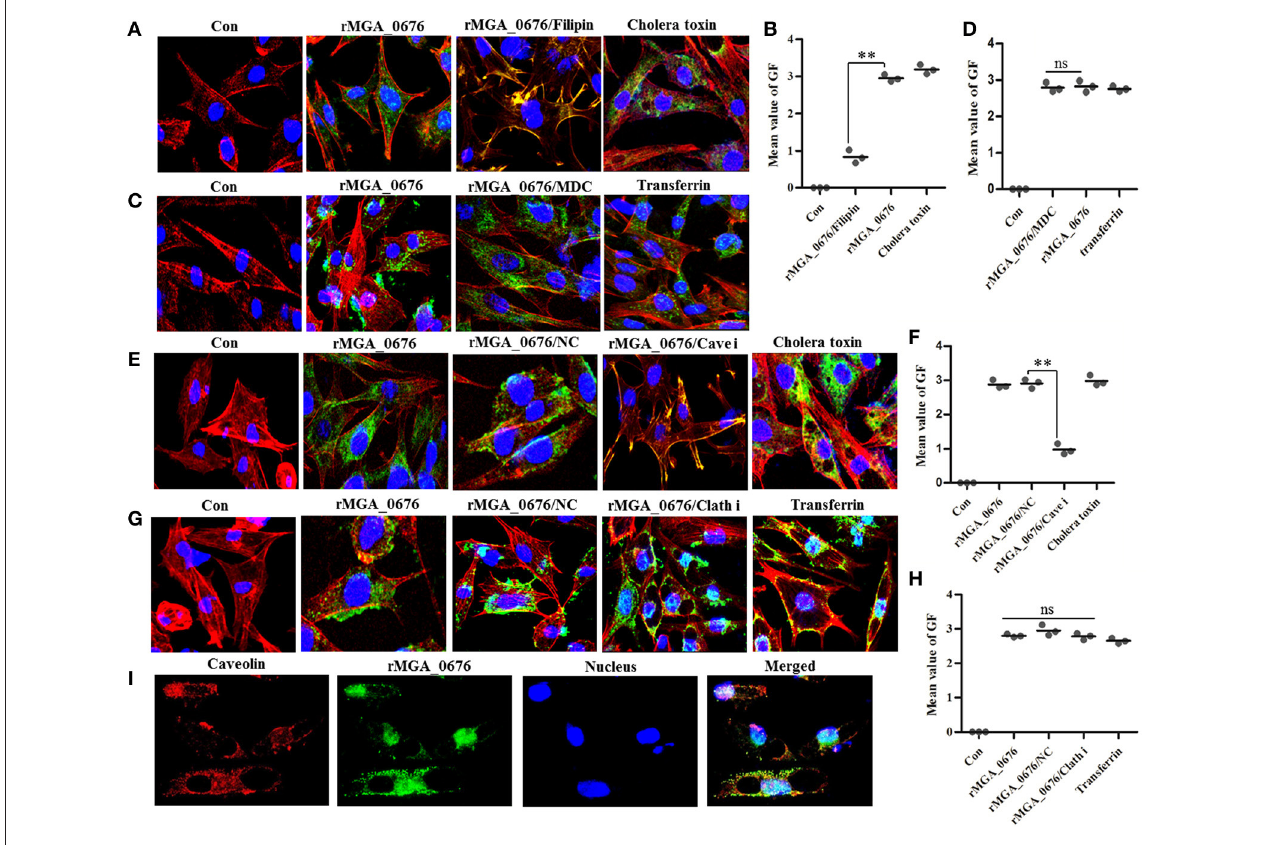
FIGURE 1 | Caveolin-mediated endocytic mechanisms are implicated in internalization of rMGA_0676. (A) Internalization of rMGA_0676 was blocked by caveolin-mediated endocytic inhibitor filipin. DF-1 cells were treated with filipin followed by rMGA_0676 (40 µ g/ml) for 24h at 37 ◦ C to detect the inhibition of rMGA_0676 internalization. The samples underwent IFA and were examined with a laser confocal scanning microscope. Cellular F-actin was stained with Alexa Fluor 555-conjugated phalloidin. The nuclei were counterstained with DAPI (blue). The rMGA_0676 was hybridized with mouse anti-His monoclonal antibody and labeled with FITC-conjugated goat anti mouse IgG antibody green fluorescence (GF). The normal DF-1 cells as the negative control (Con), cells were treated with Cholera toxin-FITC as the caveolin-mediated endocytic positive control (Cholera toxin). (B) The mean value of GF was used to quantify the positive staining for rMGA_0676 in filipin treated DF-1 cells (A) , the data were analyzed using SPSS software, and the graph was made using GraphPad Prism 5.0. “**”represented statistically significant differences ( P < 0.01). (C) Internalization of rMGA_0676 was not blocked by clathrin-mediated endocytic inhibitor MDC. DF-1 cells were treated with MDC followed by rMGA_0676 (40 µ g/ml) for 24h at 37 ◦ C and detected the inhibition of rMGA_0676 internalization underwent IFA as described above. The normal DF-1 cells as the negative control (Con), cells were treated with transferrin as the clathrin-mediated endocytic positive control (transferrin). (D) The mean value of GF was used to quantify the positive staining for rMGA_0676 in MDC treated DF-1 cells (B) , the data were analyzed using SPSS software, and the graph was made using GraphPad Prism 5.0. (E) Internalization of rMGA_0676 was reduced by knockdown of caveolin in DF-1 cells by siRNA. The caveolin siRNA sequence(si Cave) and its negative control siRNA sequence(NC) were transfected into DF-1 cells using RNAiMAX reagent followed by rMGA_0676 (40 µ g/ml) for 24h at 37 ◦ C and detected the inhibition of rMGA_0676 internalization underwent IFA as described above. The normal DF-1 cells as the negative control (Con), cells transfected with negative control siRNA sequence followed by rMGA_0676 for 24h at 37 ◦ C as the siRNA negative control (NC), cells were treated with Cholera toxin-FITC as the caveolin-mediated endocytic positive control (Cholera toxin). (F) The mean value of GF was used to quantify the positive staining for rMGA_0676 in caveolin siRNA sequence (Cave i) transfected DF-1 cells (C) , the data were analyzed using SPSS software, and the graph was made using GraphPad Prism 5.0. “**”represented statistically significant differences ( P < 0.01), “ns” represented no significant differences. (G) Internalization of rMGA_0676 was not reduced by knockdown of clathrin in DF-1 cells by siRNA. The clathrin siRNA sequence(Clath i) and its negative control siRNA sequence(NC) were transfected into DF-1 cells using RNAiMAX reagent followed by rMGA_0676 (40 µ g/ml) for 24h at 37 ◦ C and detected the inhibition of rMGA_0676 internalization underwent IFA as described above. The normal DF-1 cells as the negative control (Con), cells transfected with negative control siRNA sequence followed by rMGA_0676 for 24h at 37 ◦ C as the siRNA negative control (NC), cells were treated with transferrin as the clathrin-mediated endocytic positive control (transferrin). (H) The mean value of GF was used to quantify the positive staining for rMGA_0676 in clathrin siRNA sequence (Clath i) transfected DF-1 cells (D) , the data were analyzed using SPSS software, and the graph was made using GraphPad Prism 5.0. “**”represented statistically significant differences ( P < 0.01), “ns” represented no significant differences. (I) Co-localization of MGA_0676 and caveolin in DF-1 cells. The sections were treated with rMGA_0676 (40 µ g/ml) for 24h at 37 ◦ C followed by IFA as described above. The Sections were incubated with mouse anti-His antibody and rabbit anti-caveolin antibody for 1.5h at 37 ◦ C. Sections were then incubated with FITC-conjugated goat anti mouse IgG antibody (green) and rhodamine (tetramethyl rhodamine isocyanate [TRITC])-conjugated goat antirabbit antibody (red). Nuclei were counterstained with DAPI (blue). All the cell samples were examined with a laser confocal scanning microscope. Scale bar = 10 µ m.